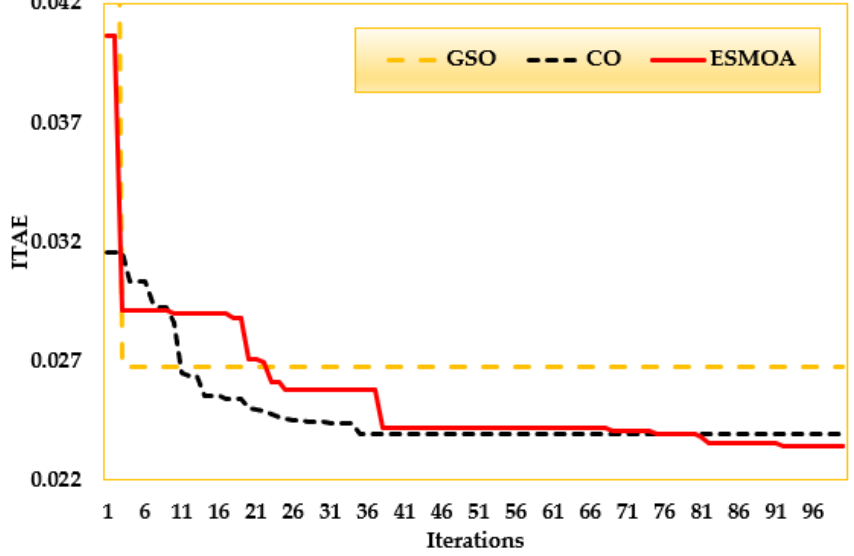
Figure 5. Converging characteristics of the suggested ESMOA, GSO, and CO techniques for Case 1.